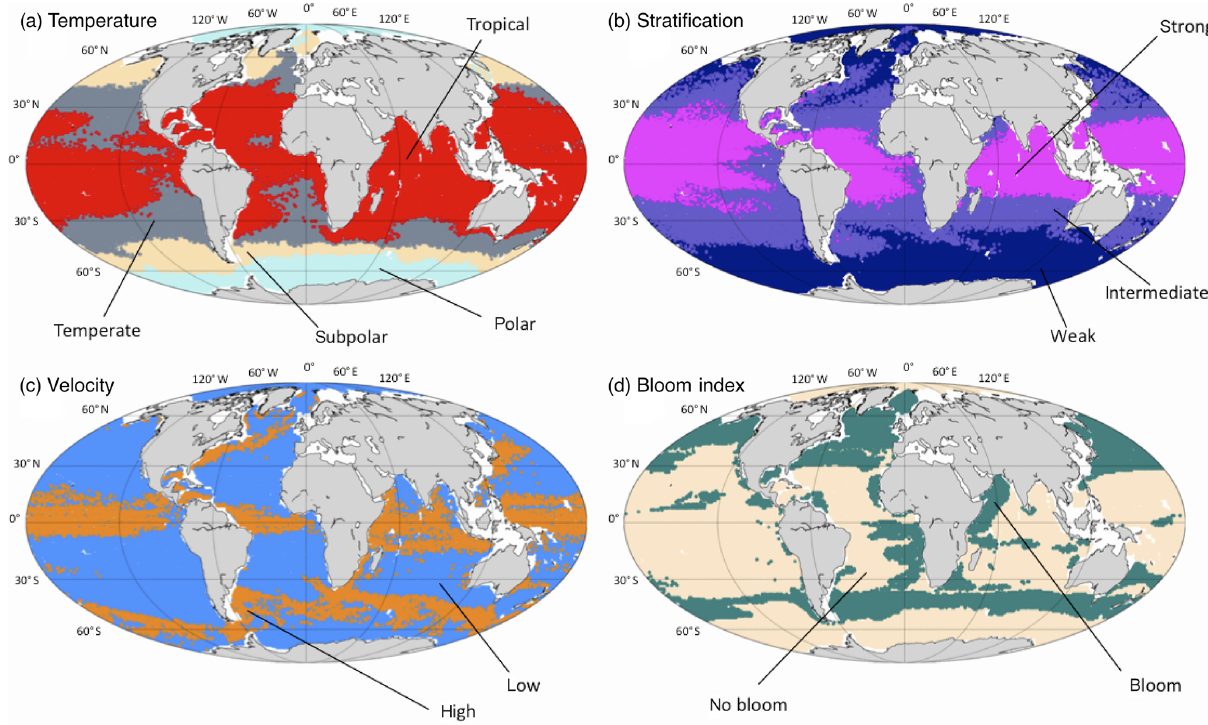
Figure 2. Spatial division of the different regimes as defined in Table 2. (a) Temperature: polar (pale blue), subpolar (yellow), temperate (gray) and tropical (red). (b) Stratification: weak (dark blue), intermediate (purple) and strong (magenta). (c) Current velocities: low (blue) and high (orange). (d) Bloom index: bloom (green) and no bloom (beige). Each point of the subset S N has been plotted at its spatial location with a color corresponding to the regime it belongs